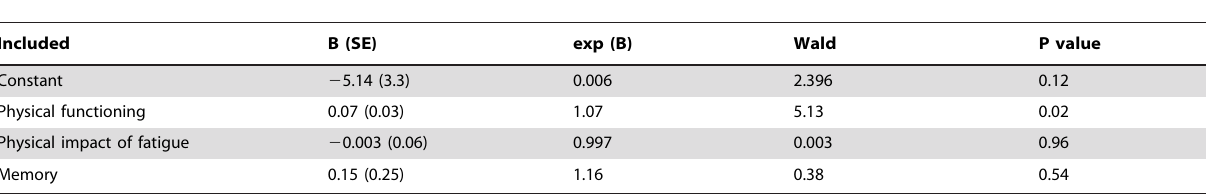
Table 3. Logistic regression model of employment status.